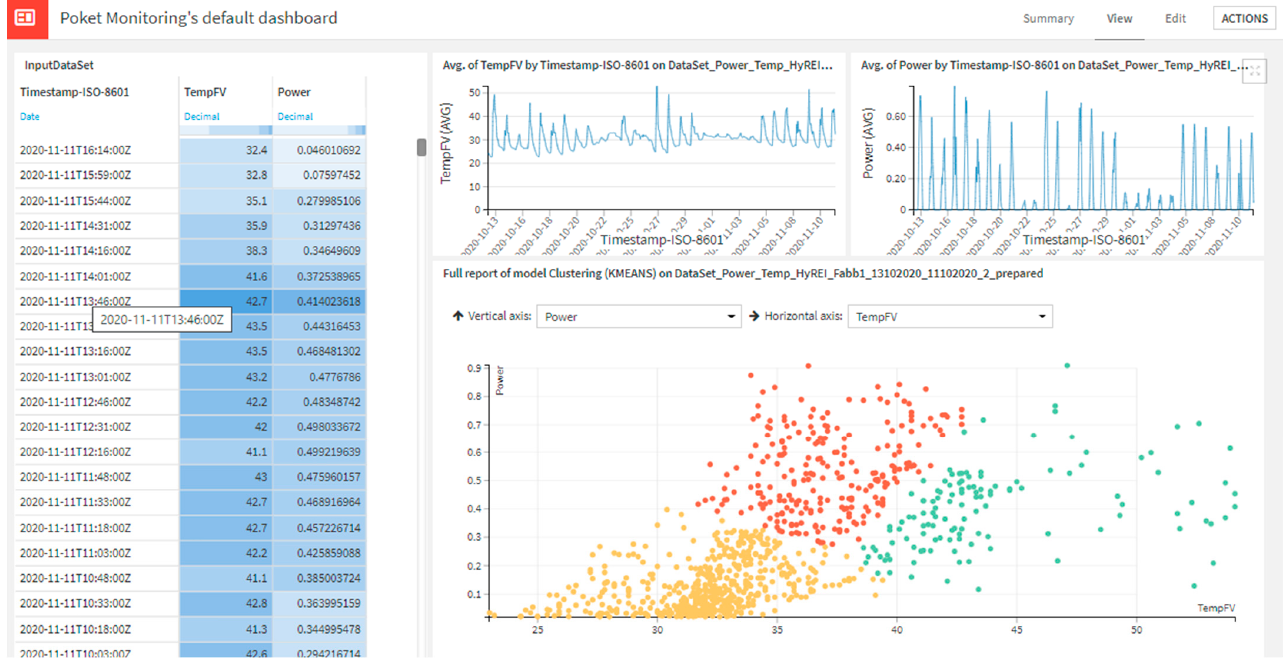
Figure 7. Summary of results obtained and analyzed using the dashboard.